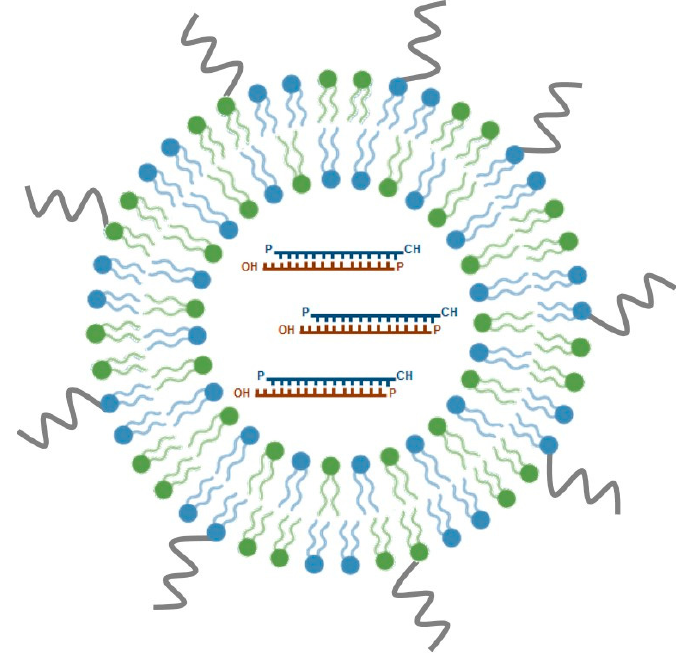
Figure 3. Schematic representation of stable nucleic acid lipid particles (SNALPs). SNALPs are a particular class of lipid nanoparticles (LNPs), which comprise cationic lipids (in blue), non-ionic lipids (in green), and polyethylene glycol (in grey; see text for details). SNALPs are nanoparticles, displaying optimal physico-chemical features for in vivo delivery of therapeutic nucleic acids, such as siRNAs. siRNAs are enclosed in the hydrophilic core of the nanoparticle. These siRNA-lipid particles show considerably enhanced cellular internalization and endosomal escape of siRNA. Several SNALP- formulated siRNA therapeutic molecules have reached clinical trials and are currently being evaluated for efficacy. The most well-known example is Patisiran ® , the first FDA-approved siRNA drug.